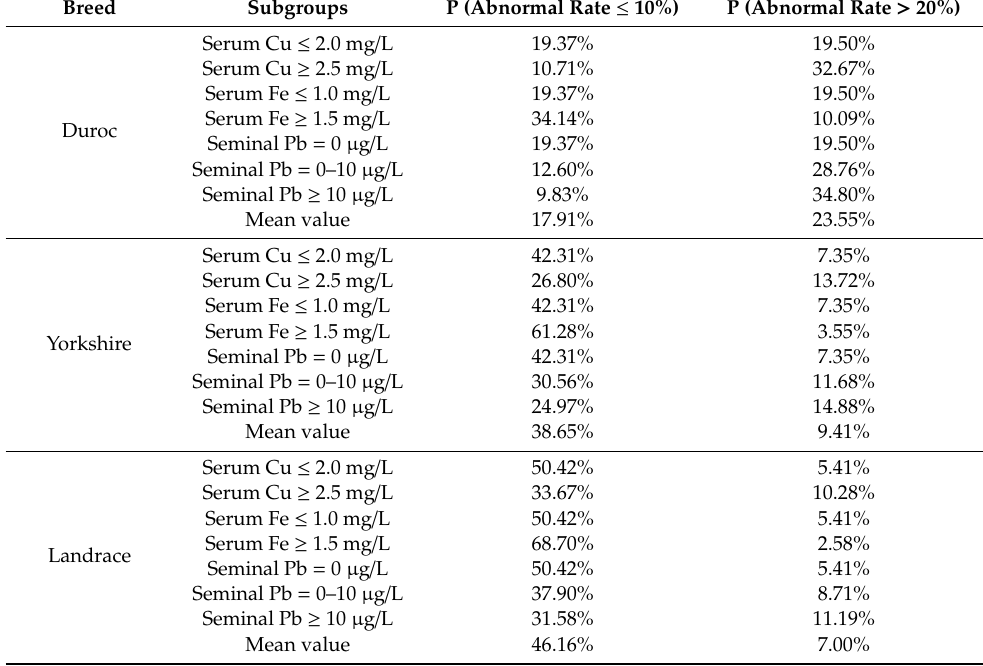
Table 8. Prediction of the occurrence probability of boar abnormal sperm morphology less than 10% or greater than 20% under di ff erent breeds and element